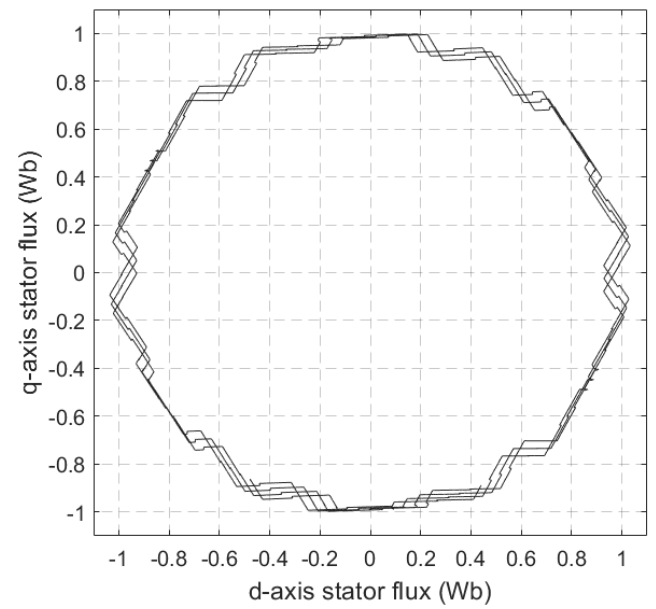
Figure 10. Stator magnetic flux path in the d–q-axis reference frame.